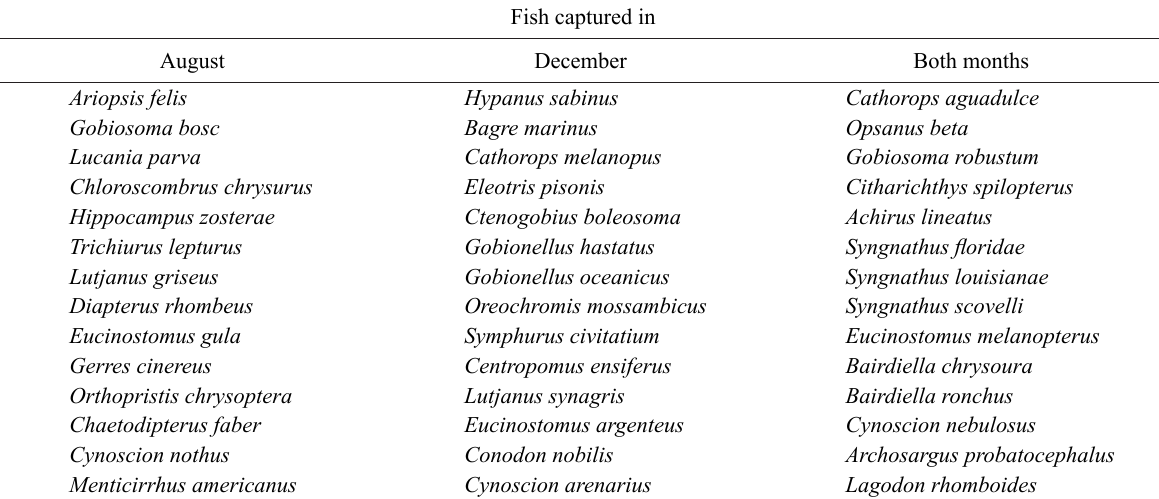
Capture seasonality of fish species collected in 1996 in the Laguna de Tamiahua, Gulf of Mexico,